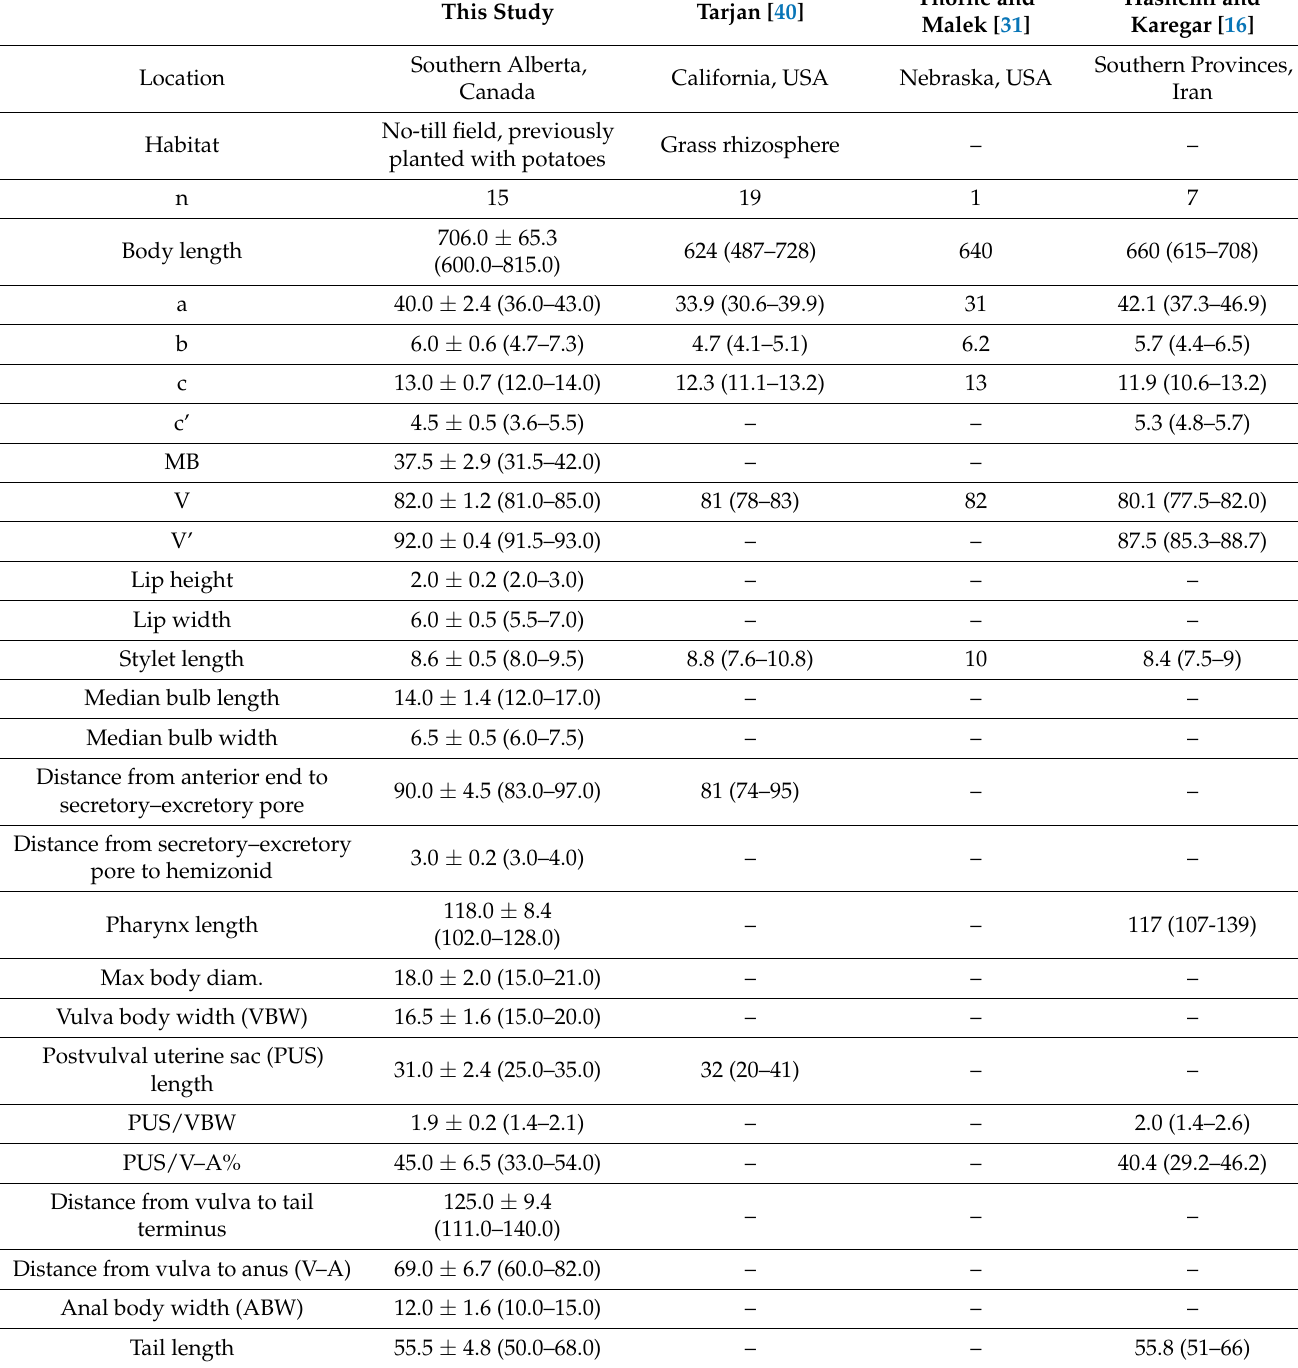
Table 1. Comparative morphometrics of all the reported populations of Ditylenchus anchilisposomus (female) (Tarjan) Fortuner [28,40]. All measurements are in µ m and in the form: mean ± standard deviation (range), or mean (range), or mean (Nebraska isolate). This Study Tarjan [40]